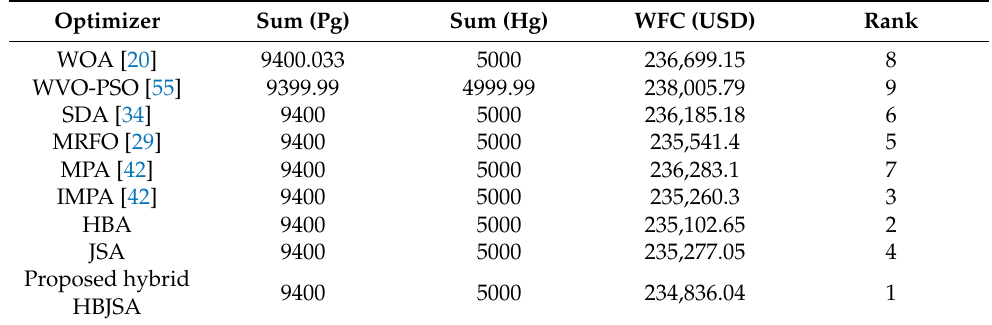
Table 8. Comparison between HBA, JSA, and HBJSA with respect to reported techniques for the 96-unit test system of CHP economic dispatch